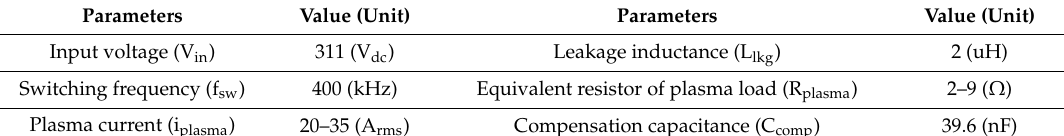
Figure 9. Loss analysis of each resonant network: ( a ) loss according to load variation in the LCL network; ( b ) loss according to load variation in the LCCL network.